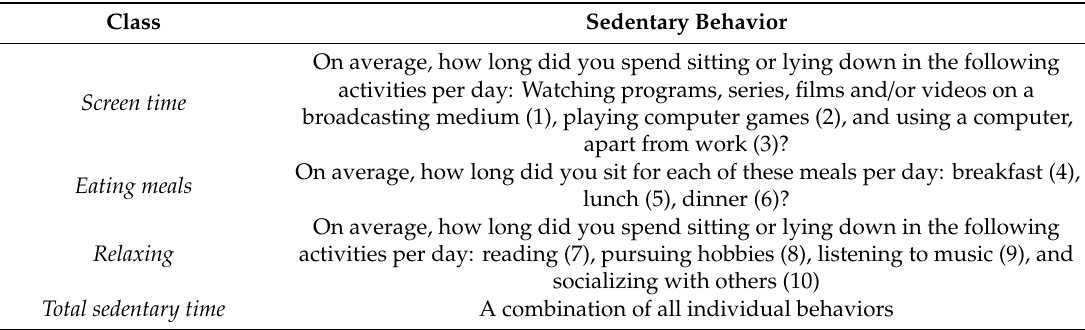
Table 1. Sedentary behaviors covered in our